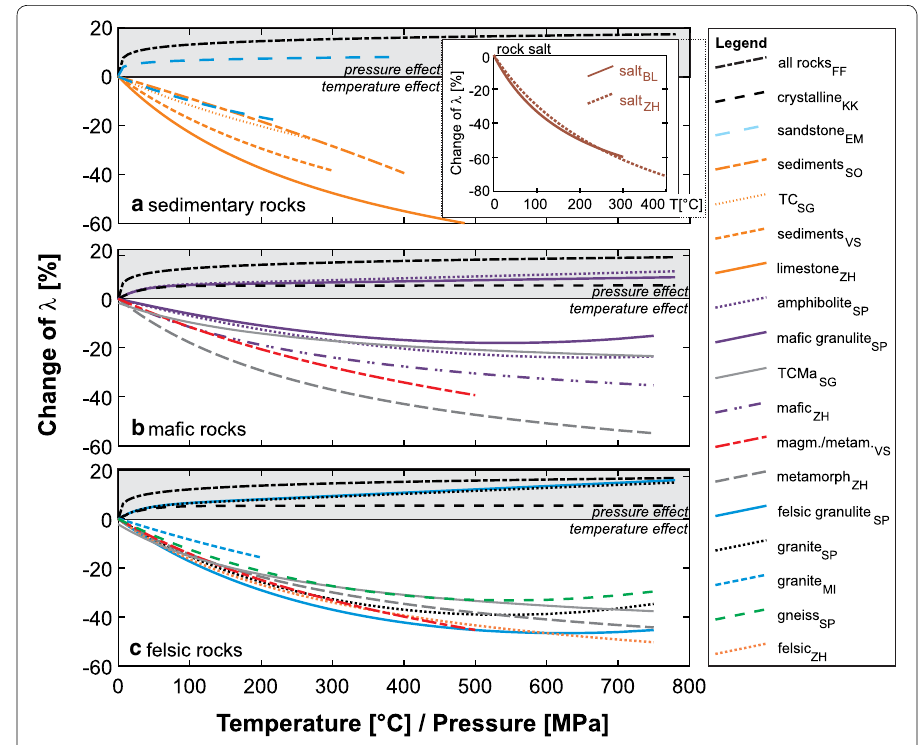
Fig. 1 Relative change of thermal conductivity ( λ ) based on different p / T corrections ( p corrections with increased λ , grey shaded area; T corrections with decreased λ ): a for sedimentary rocks with a start value at ambient conditions ( λ 0 ) of 2.8 W m − 1 K − 1 (except for salt inset with λ 0 5.8 W m − 1 K − 1 ); b for mafic rocks = (magmatic or metamorphic) with a λ 0 of 2.4 W m − 1 K − 1 , and c for felsic rocks (magmatic or metamorphic) with a λ 0 of 3.0 W m − 1 K − 1 . The main rock type as specified by the respective author is denoted. Authors are abbreviated as follows: BL: Blesch et al. (1983); EM: Emirov et al. (2017); FF: Fuchs and Förster (2014); KK: Kukkonen et al. (1999); MI: Eq. 4 of Miranda et al. (2019); SO: Somerton (1992); SP: Seipold (2001); VS: Vosteen and Schellschmidt (2003); SG: Sekiguchi (1984); ZH: Zoth and Haenel